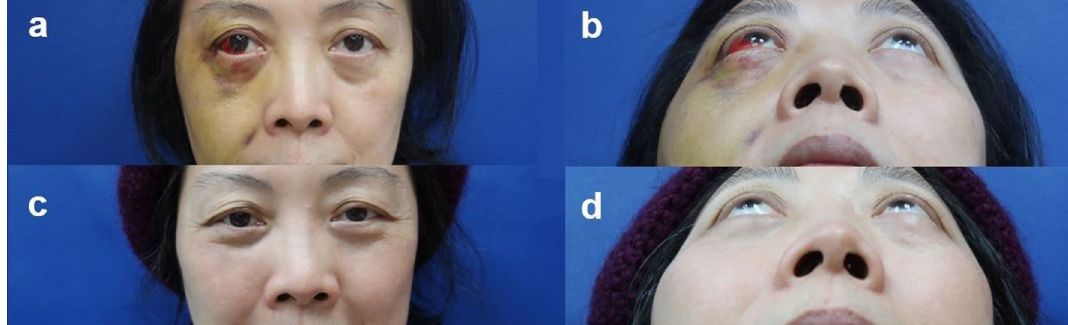
Figure 2. Clinical outcomes of facial symmetry and enophthalmos. The patient presented with right malar depression after zygomatico-orbital fractures in the preoperative frontal and axial views ( a , b ). Six months after surgery, the patient reported symmetric projection of both the eyeballs and bilateral malar eminence ( c , d ), and the results were esthetically